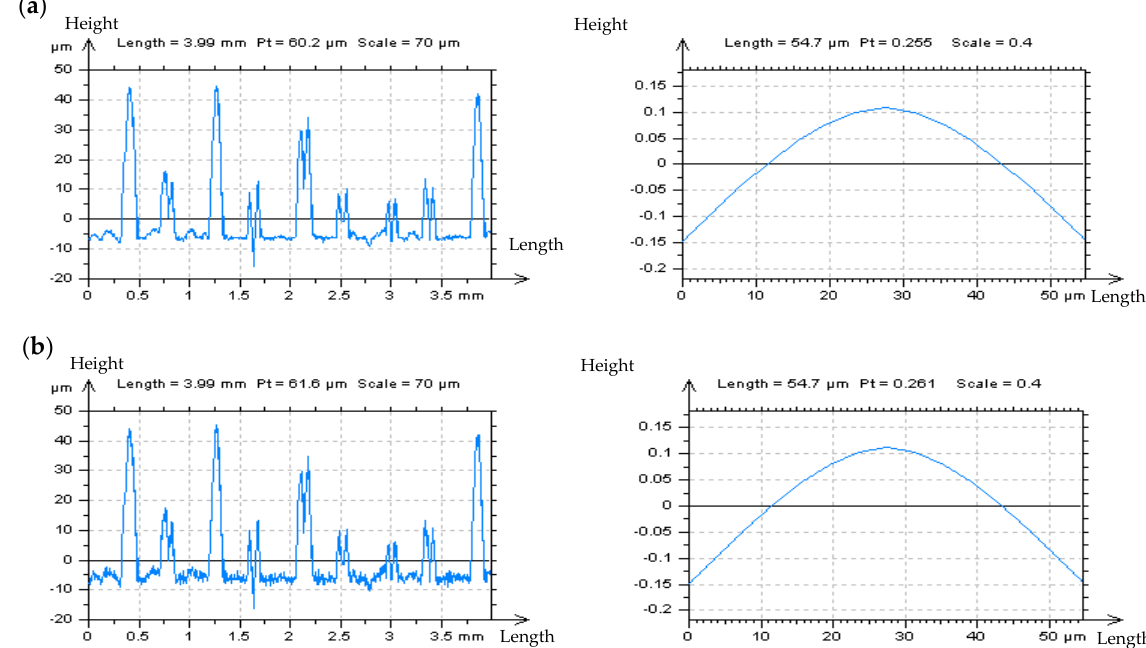
Figure 7. The profiles and their ACF centre–parts, decomposed from laser-textured surfaces, measured with the stylus technique at the speed of ( a ) 0.5 mm/s and after adding a modelled high-frequency noise with Sq equal to 20% of the Sq of considered detail ( b ).